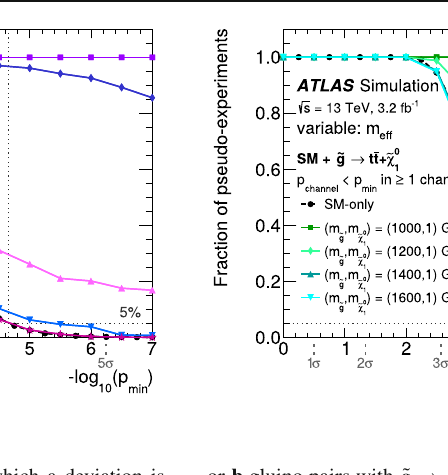
decays and various masses. The line or b gluino pairs with ˜ g → t ¯ t ˜ χ 0 1 corresponding to the injection of a Z (cid:8) boson with a mass of 4 TeV and a gluino with a mass of 1600 GeV overlap with the line obtained from the SM-only pseudo-experiments due to the small signal